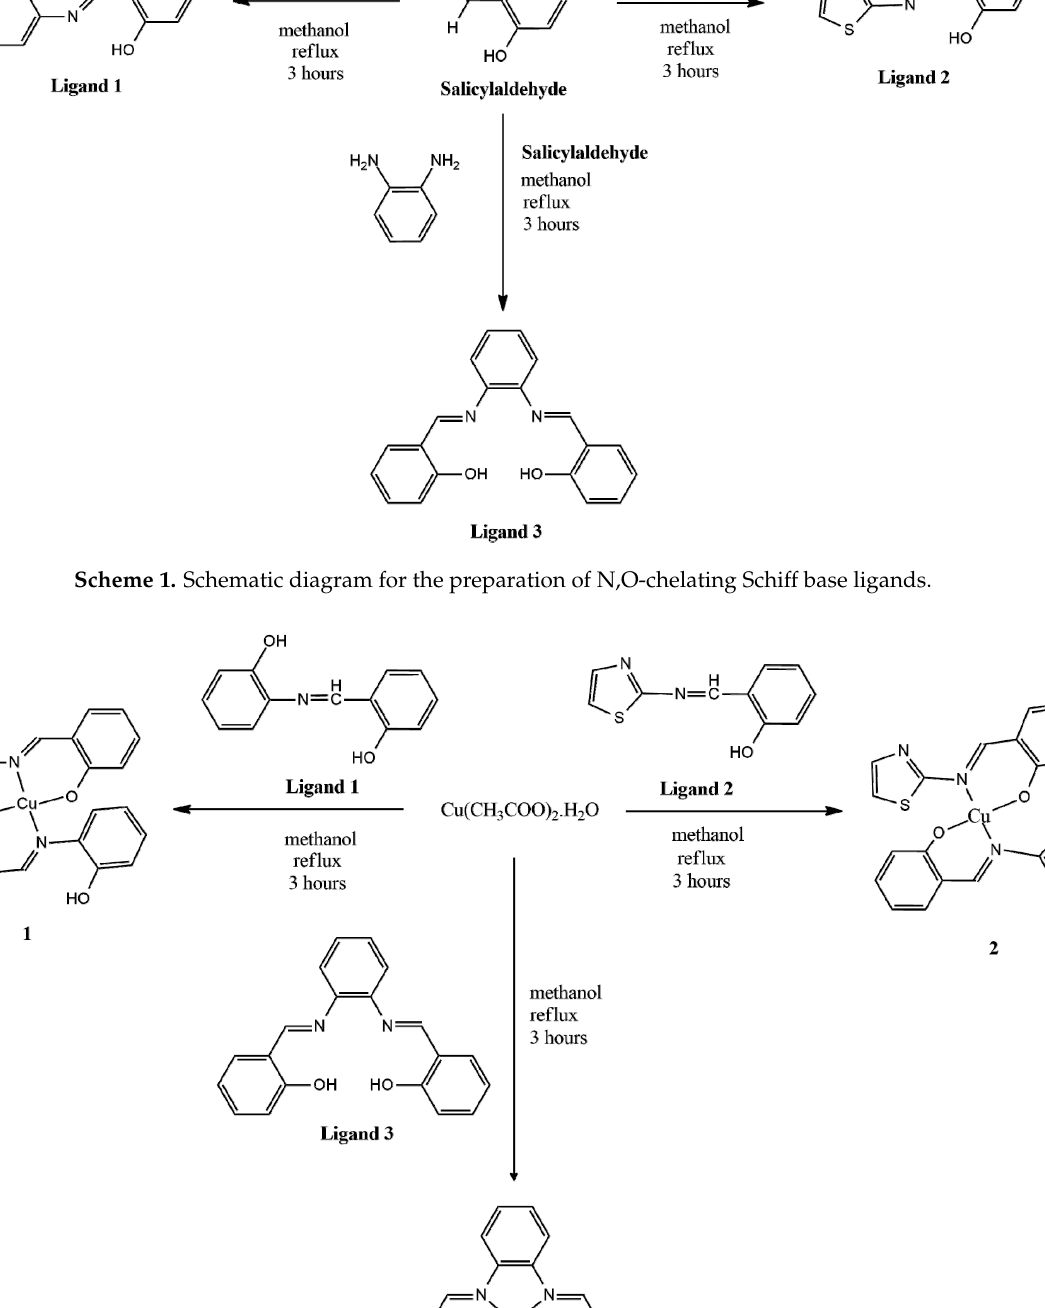
Table 1. Elemental analysis of 1, 2 and 3 . Element